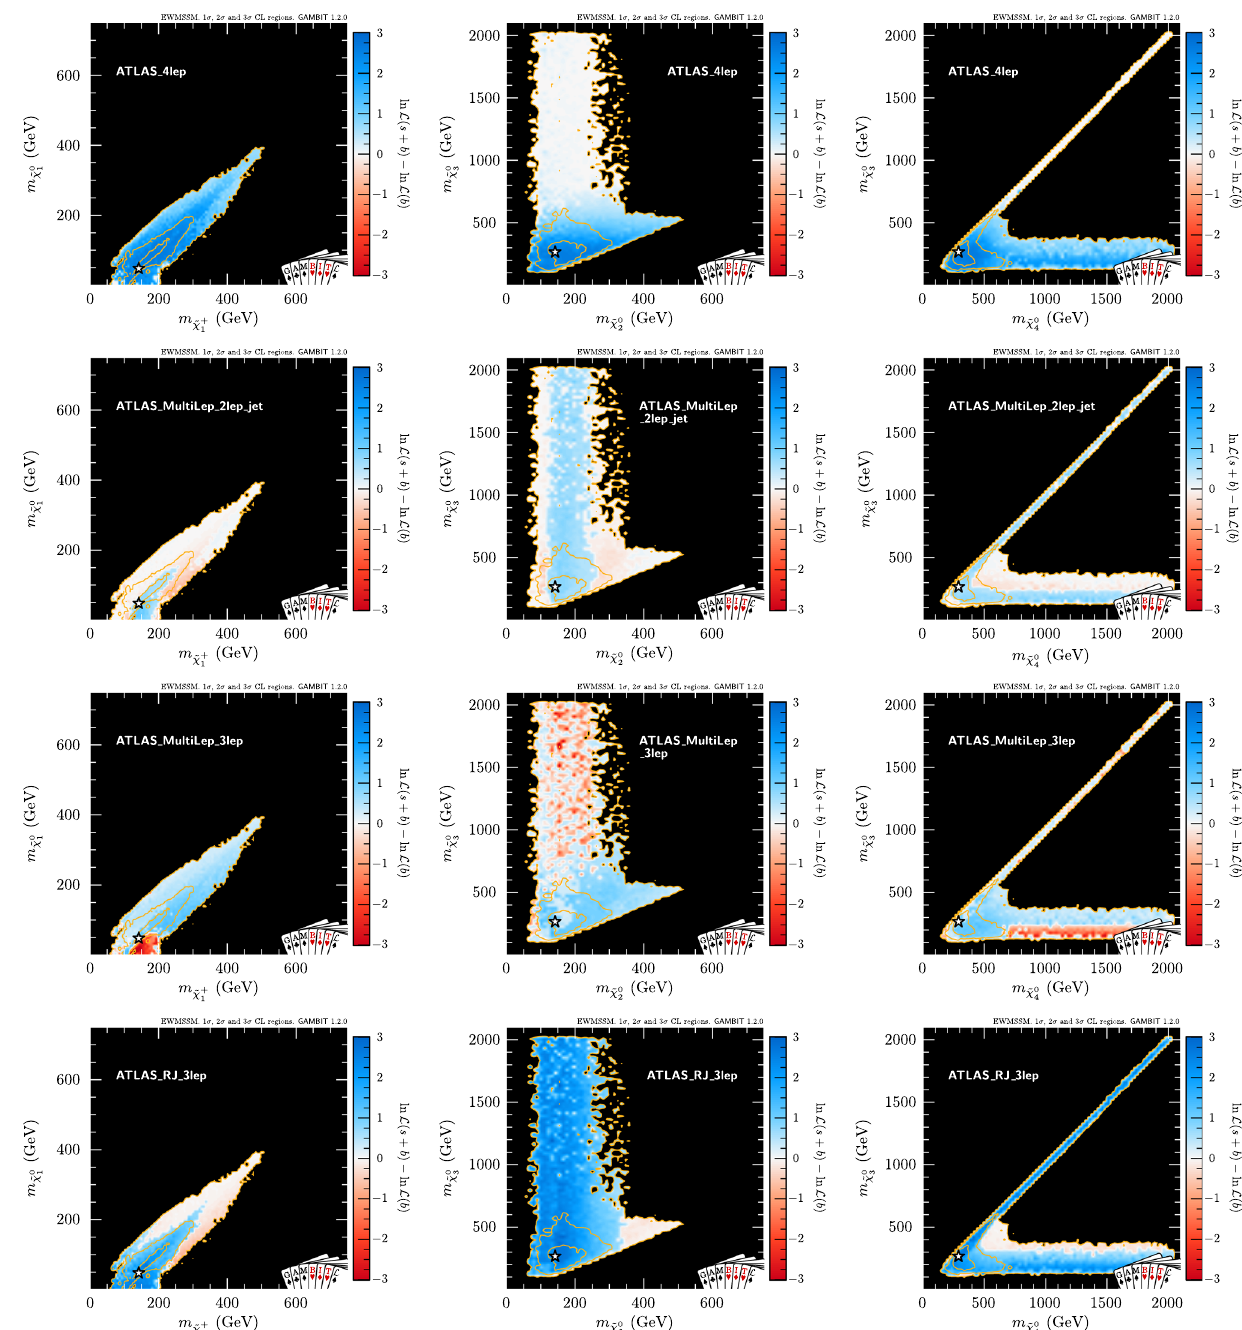
Fig. 9 The1 σ ,2 σ and3 σ regions(orangelines)preferredbyourcom- ATLAS_MultiLEP_2lep_2jet (second row), ATLAS_MultiLEP_3lep (third row), and ATLAS_RJ_3lep (bottom) searches. Blue indicates bination of searches in the ˜ χ ± versus ˜ χ 0 (left), ˜ χ 0 versus ˜ χ 0 (middle) 1 1 2 3 that the signal improves the fit to that search and red that it worsens the and ˜ χ 0 versus ˜ χ 0 (right) mass planes. The colors (where present) show 4 3 fit the contribution to the total log-likelihood from the ATLAS_4lep (top),